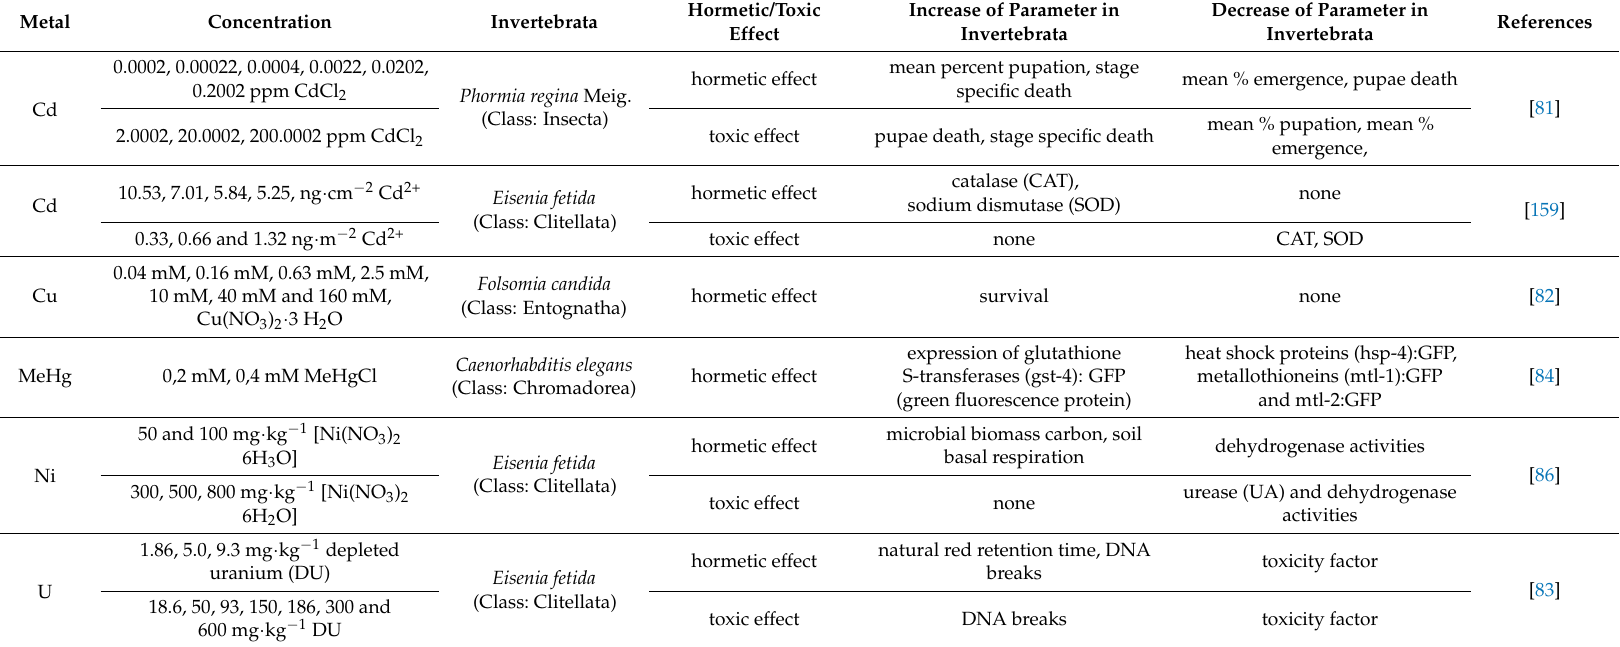
Table 2. Effects of heavy metals at hormetic and toxic doses on